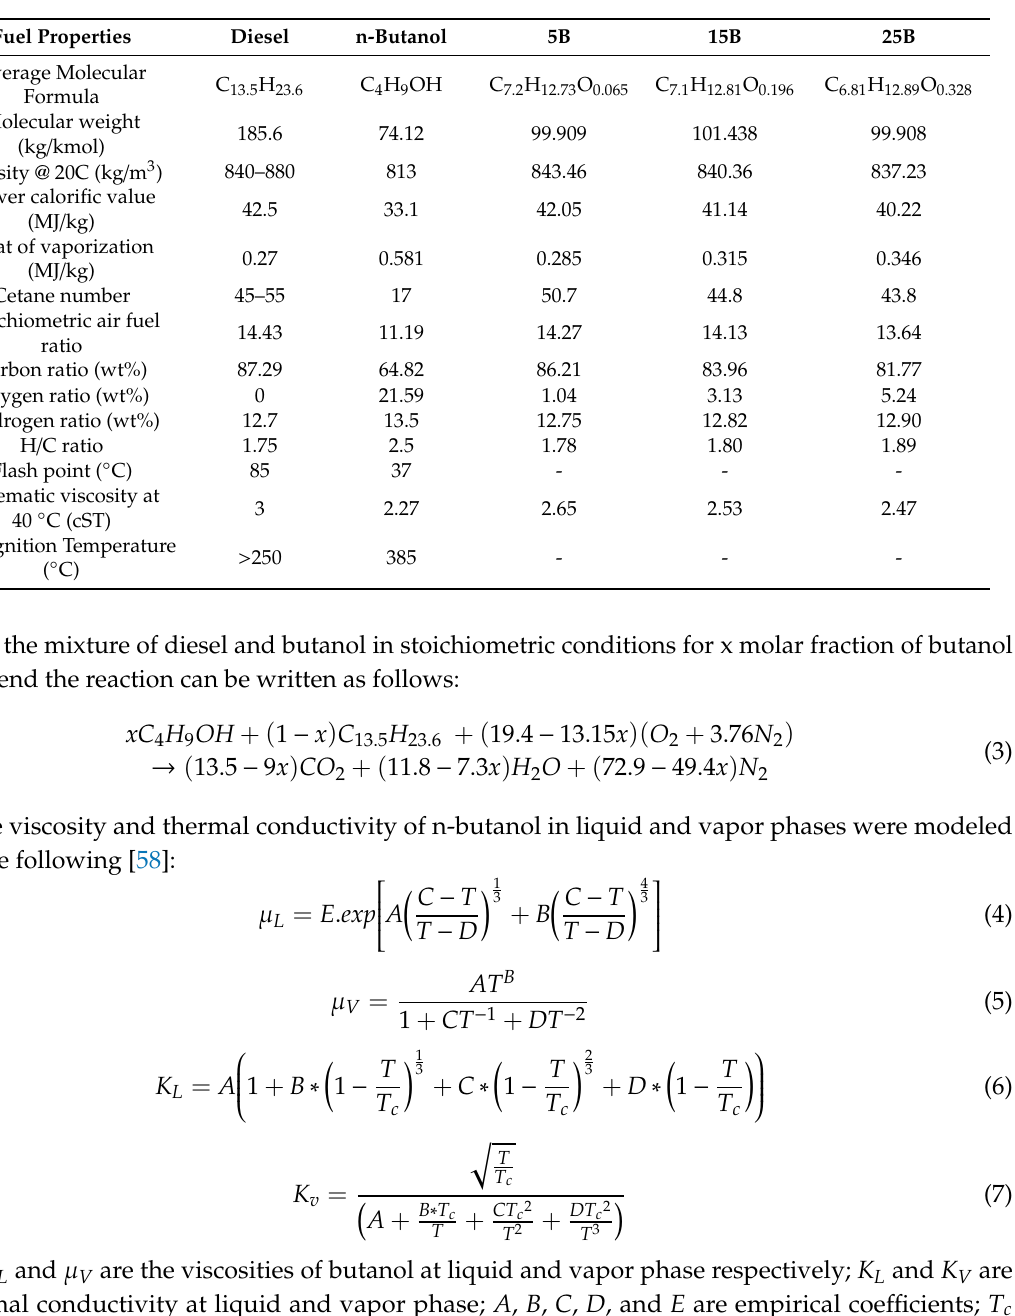
Table 3. Diesel and butanol